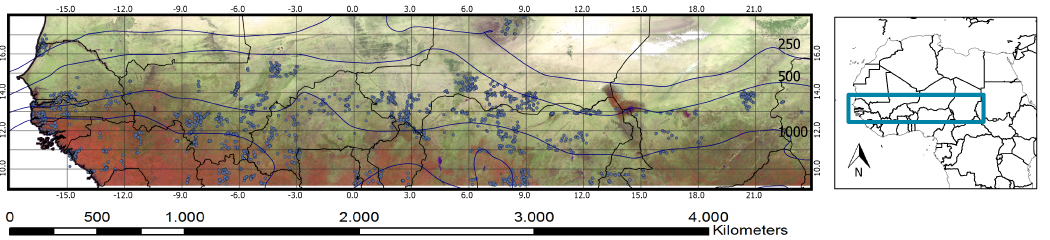
Figure 2. Study site with the validation sample (blue points) and regional grid (in grey) with isohyets of 250-mm, 500-mm and 1000-mm. The background image corresponds to the surface reflectances in infrared, mid-infrared and red bands for the dates corresponding to the maximum of red reflectance (maximum red feature).